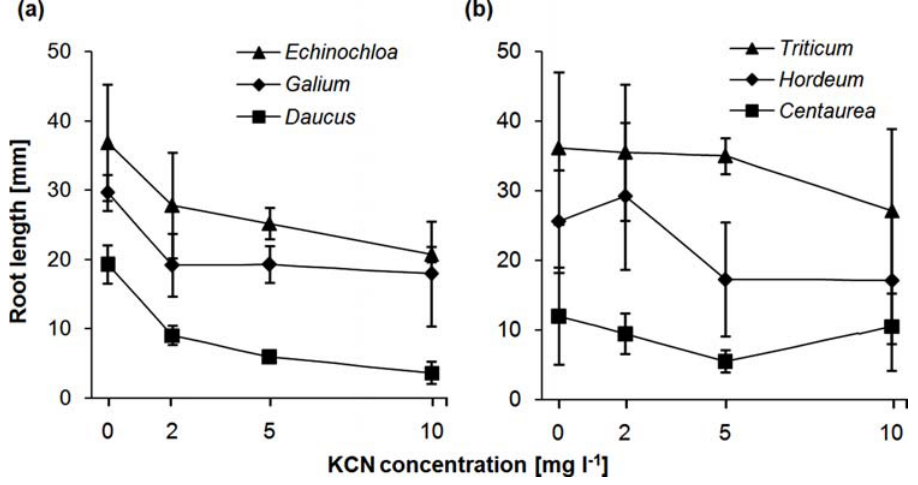
Figure 1. Cyanide-sensitivity bioassay. Reduction in root length caused by cyanide (KCN) application to weed and crop seedlings: (a) group of plant species that showed a more sensitive reaction to cyanide, (b) group of plant species that showed a less sensitive reaction. The error bars indicate the standard deviation of the means (n=4). Only the names of the plant genera are given (for species names see text). doi:10.1371/journal.pone.0000846.g001 PLoS ONE |